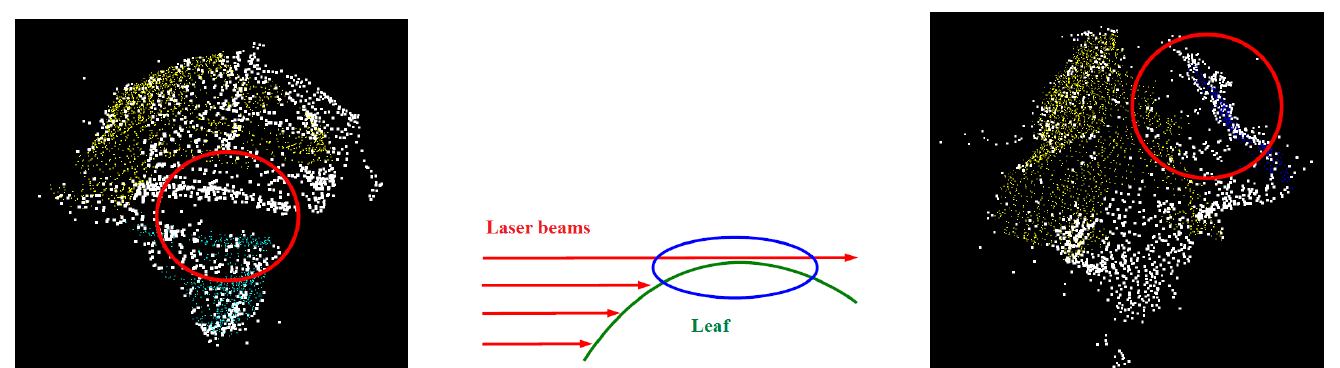
Figure 13. ( Left ): A data gap impedes the merging of the yellow- and green-coloured segments. The white class consists of points which are not allocated to any leaf. ( Middle ): Horizontal laser beams fail to acquire horizontal oriented leafs. ( Right ): Oversegmentation caused by the horizontal laser